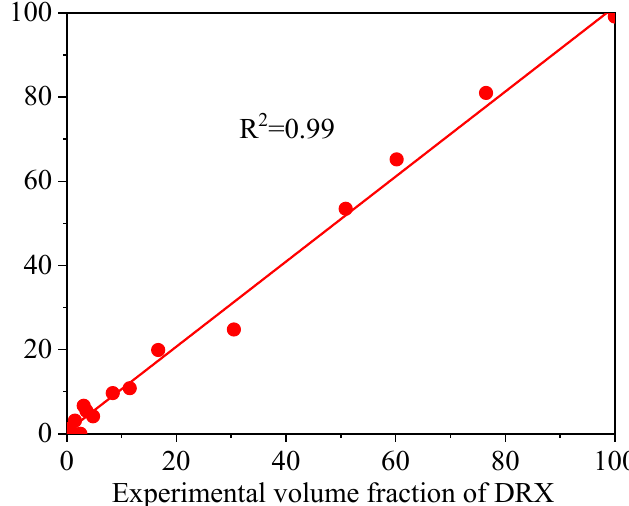
Figure 14. Correlation between the FEM and experimental volume fraction of DRX for 47Zr-45Ti-5Al-3V alloys after hot deformation.